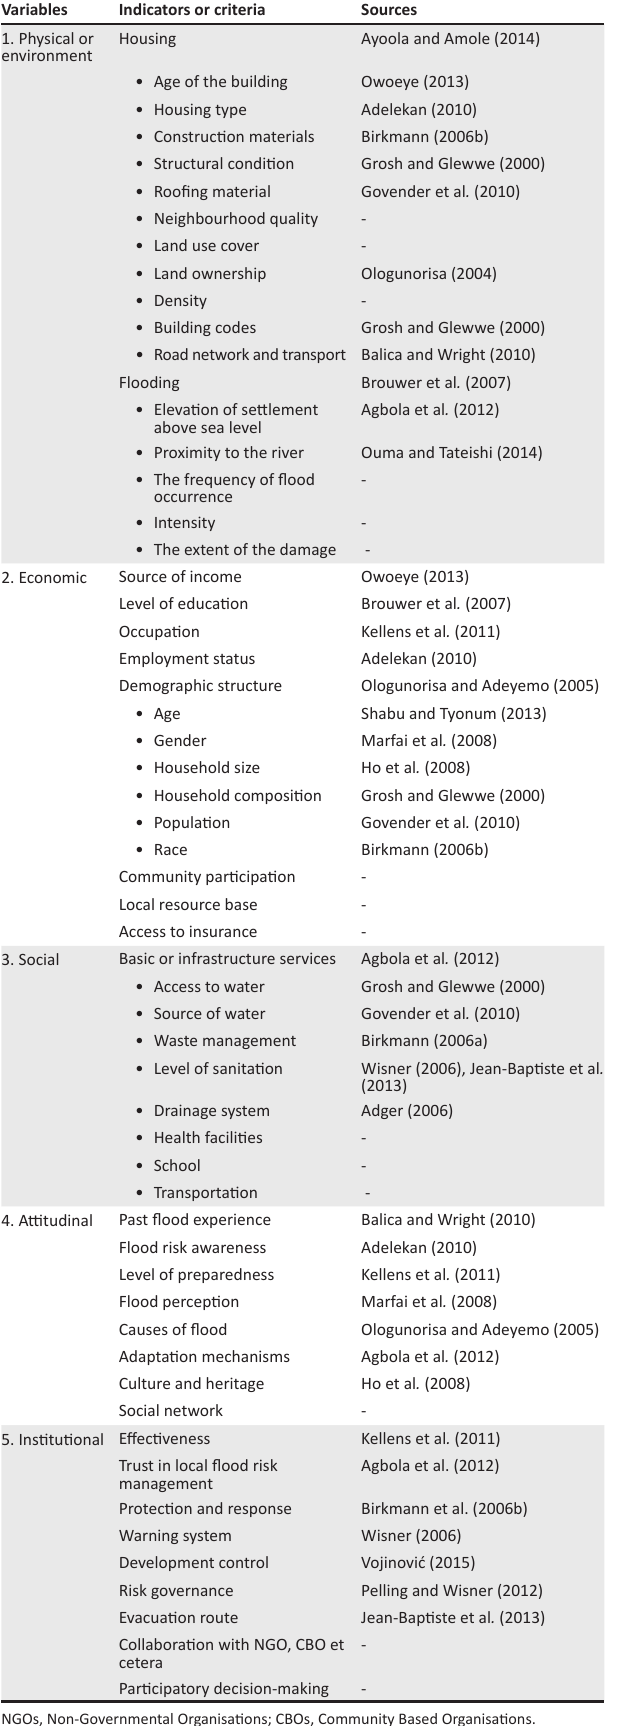
TABLE 1: Identification of flood vulnerability indicators or criteria. Variables Indicators or criteria